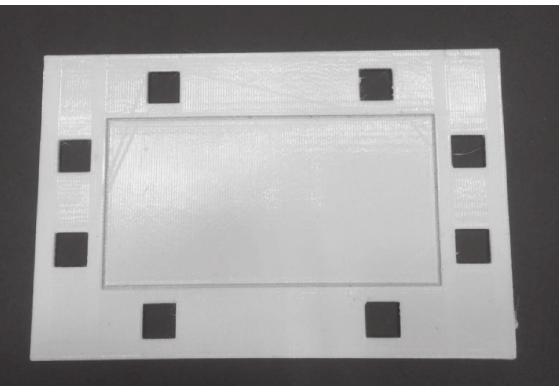
Figure 13: Specimen for experimental modal analysis (Case 3).